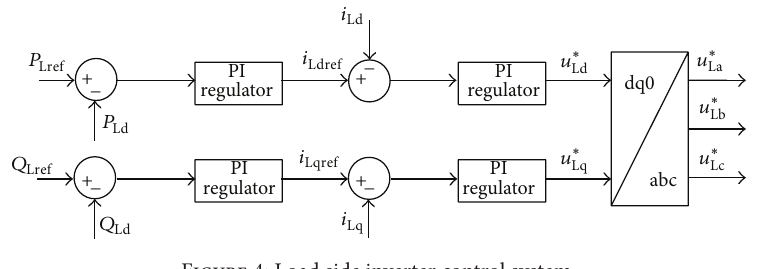
Figure 4: Load side inverter control system.